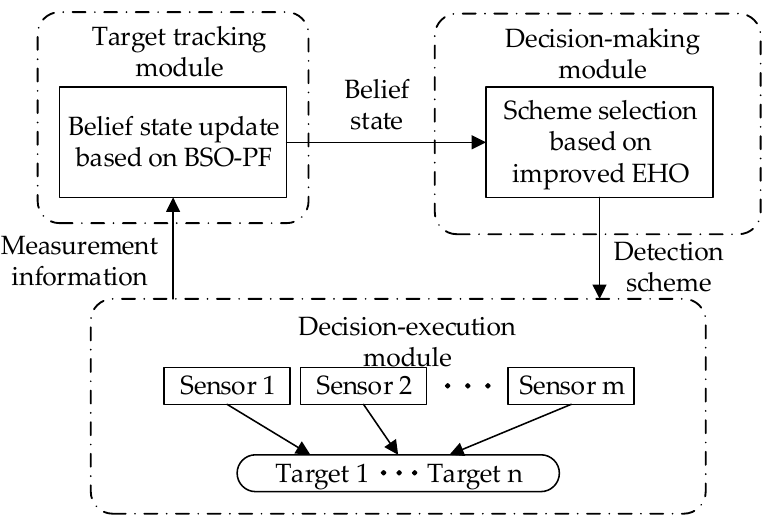
Figure 1. Multi-sensor collaborative scheduling framework.